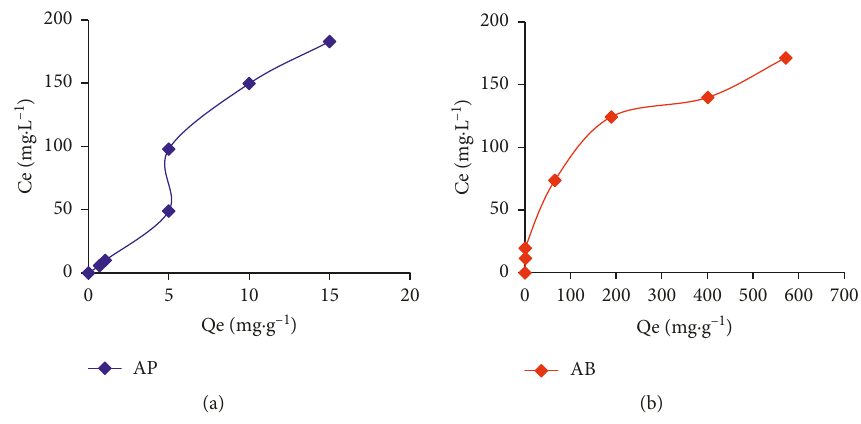
Figure 12: Adsorption isotherms of AP (a) and AB (b).